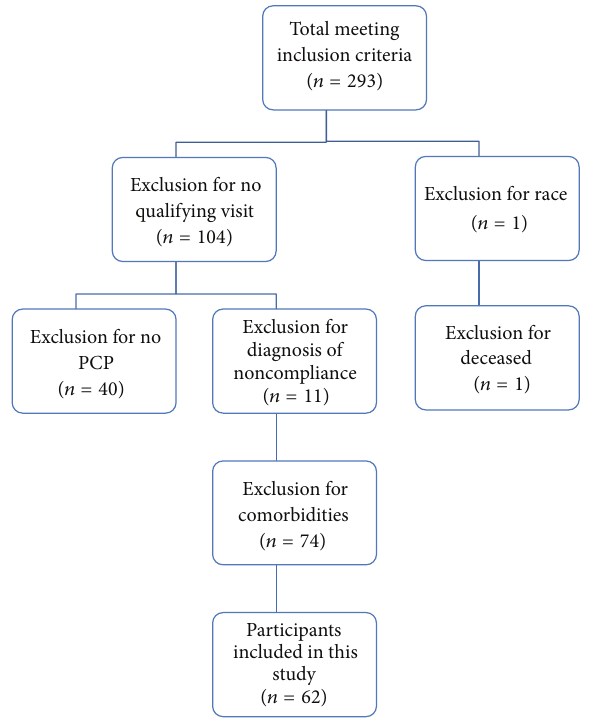
Figure 2: Participant selection algorithm.